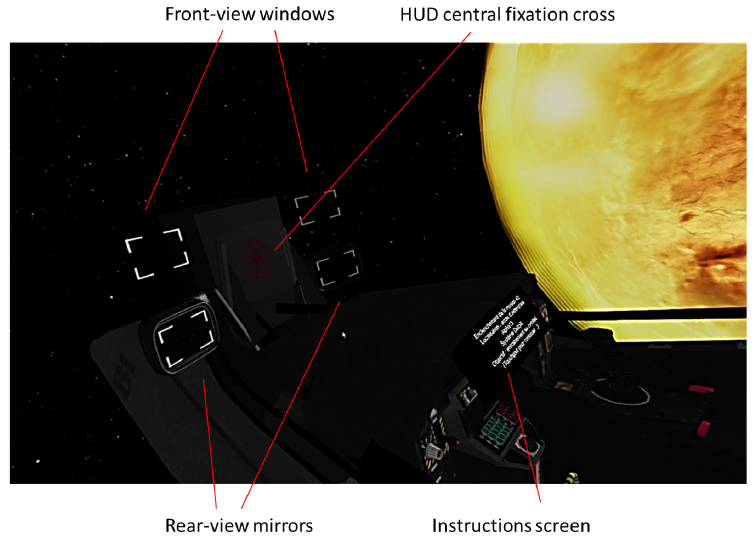
Figure 1. The view of the environment. We used two types of cues: voice instructions corresponding to endogenous audio cues and directional arrows as endogenous visual cues. The voice instructions were the French translation of “Front left”, “Rear left”, “Front right”, and “Rear right” or “Left Front”, “Left Rear”, “Right Front”, and “Left Rear”. Word order was reversed according to the subjects. The arrows were 0.02 ◦ × 0.06 ◦ . The voice instructions had a duration of 500–600 ms and the directional arrow was displayed for 300 ms. Given that the interstimulus interval (ISI) is 300 ms, the stimulus onset asynchrony (SOA) was 800–900 ms for the voice instruction and 600 ms for the directional arrow. The SOA was not manipulated in the experiment but was chosen to allow sufficient time for participants to interpret it and direct their attention voluntarily (based on